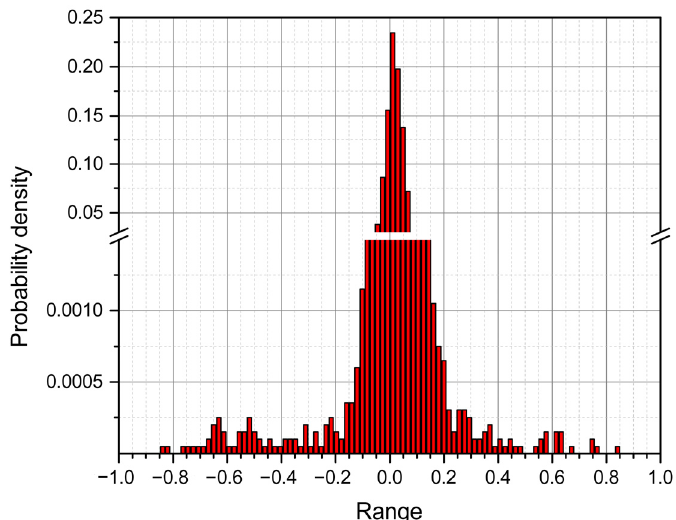
Figure 3. Artifact distribution after autoregressive RRI modeling in a separate case.